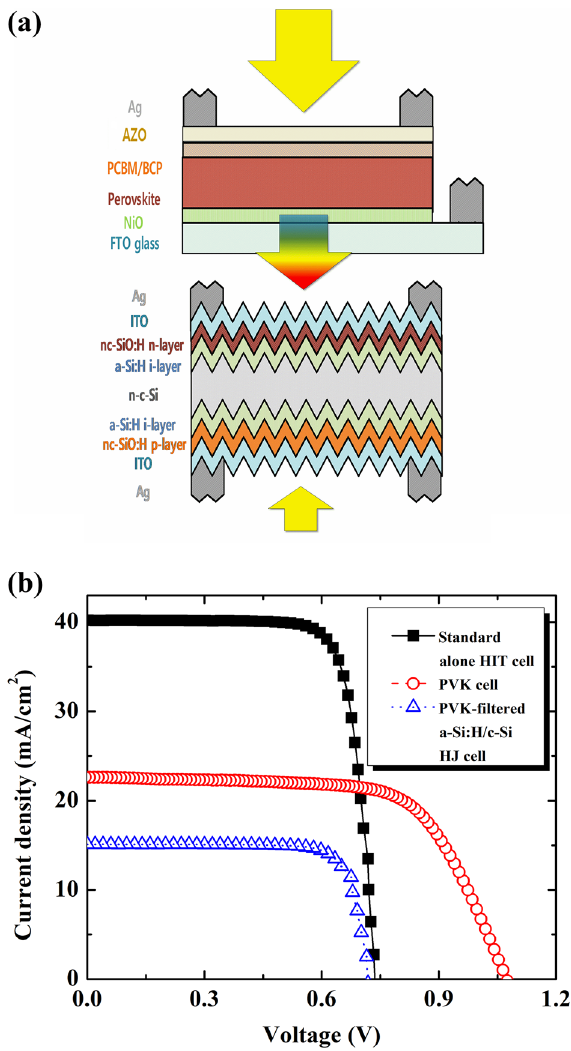
Figure 3. ( a ) Schematic of the bifacial 4-terminal PVK/c-Si HJ tandem solar cell with albedo reflection. ( b ) Illuminated current–voltage curves under 1 sun of the standard-alone c-Si HJ solar cell (black color), PVK filtered c-Si HJ solar cell (blue color) and the PVK solar cell (red